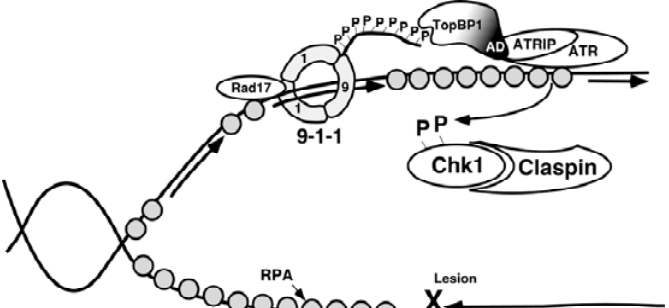
Figure 3. Model of the activation of ATR through Rad9 and TopBP1. See text for details. Modified from